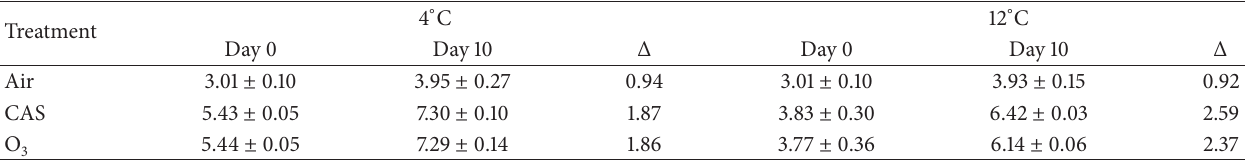
Table 1: Yeast counts (log CFU/g) and increase over 10 days ( Δ ) of highbush blueberries stored at 4 ∘ C or 12 ∘ C under controlled atmosphere ), or regular atmosphere (Air). storage conditions (CAS), ozone (O 3